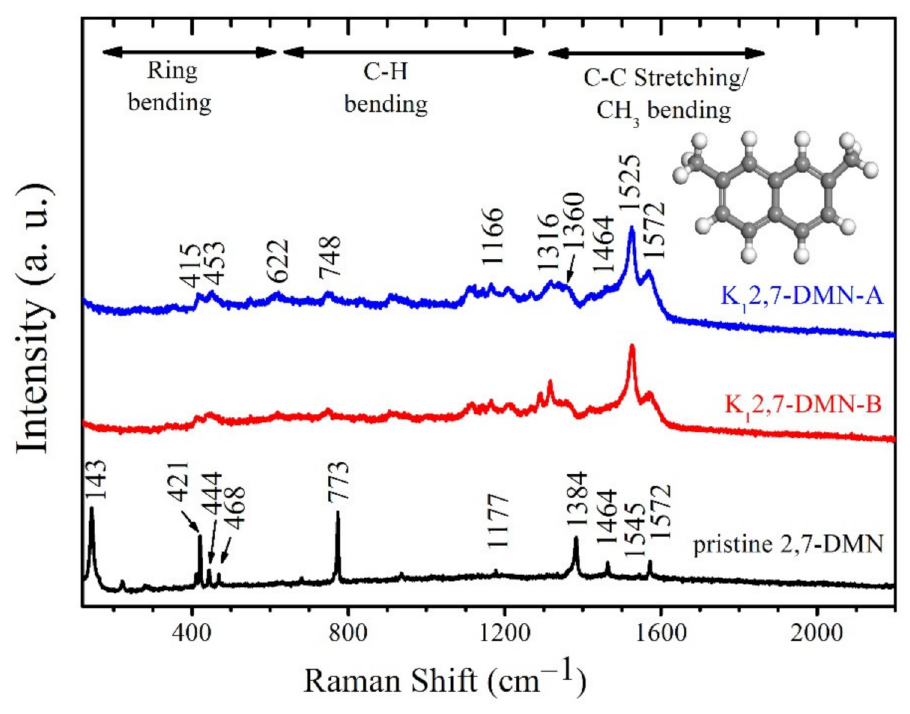
Figure 4. Raman spectroscopy of pristine and potassium-intercalated 2,7-DMN samples collected at room